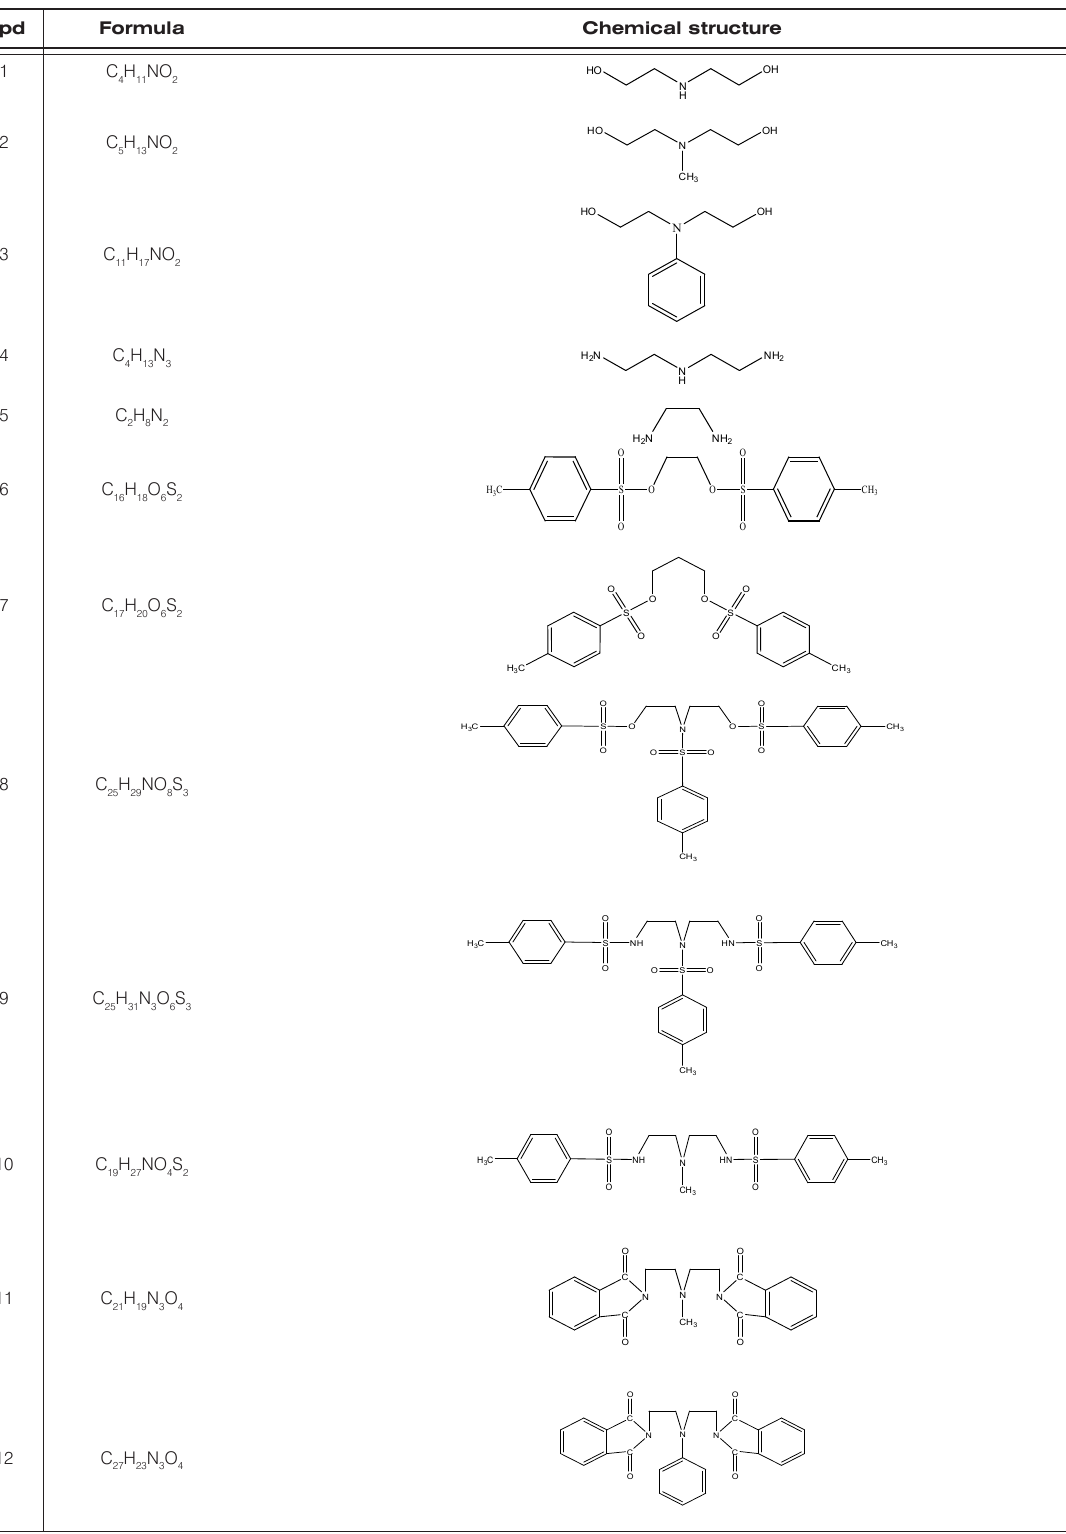
Table 1. Structure of the precursors of peraza crown